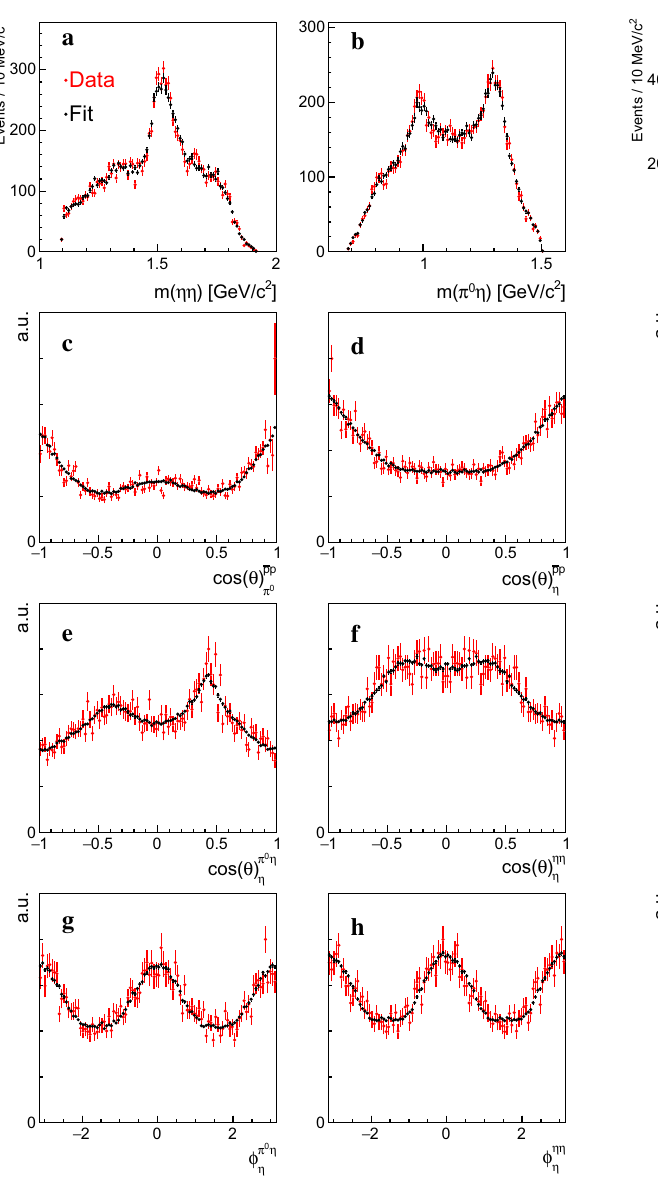
Fig. 8 Not acceptance corrected invariant ηη and π 0 η mass distribu- tions ( a , b ), acceptance corrected decay angular distributions for the production ( c , d ) and for the decay ( e – h ) of the reaction ¯ pp → π 0 ηη . The data are marked with red and the fit result is illustrated by black dots with error bars